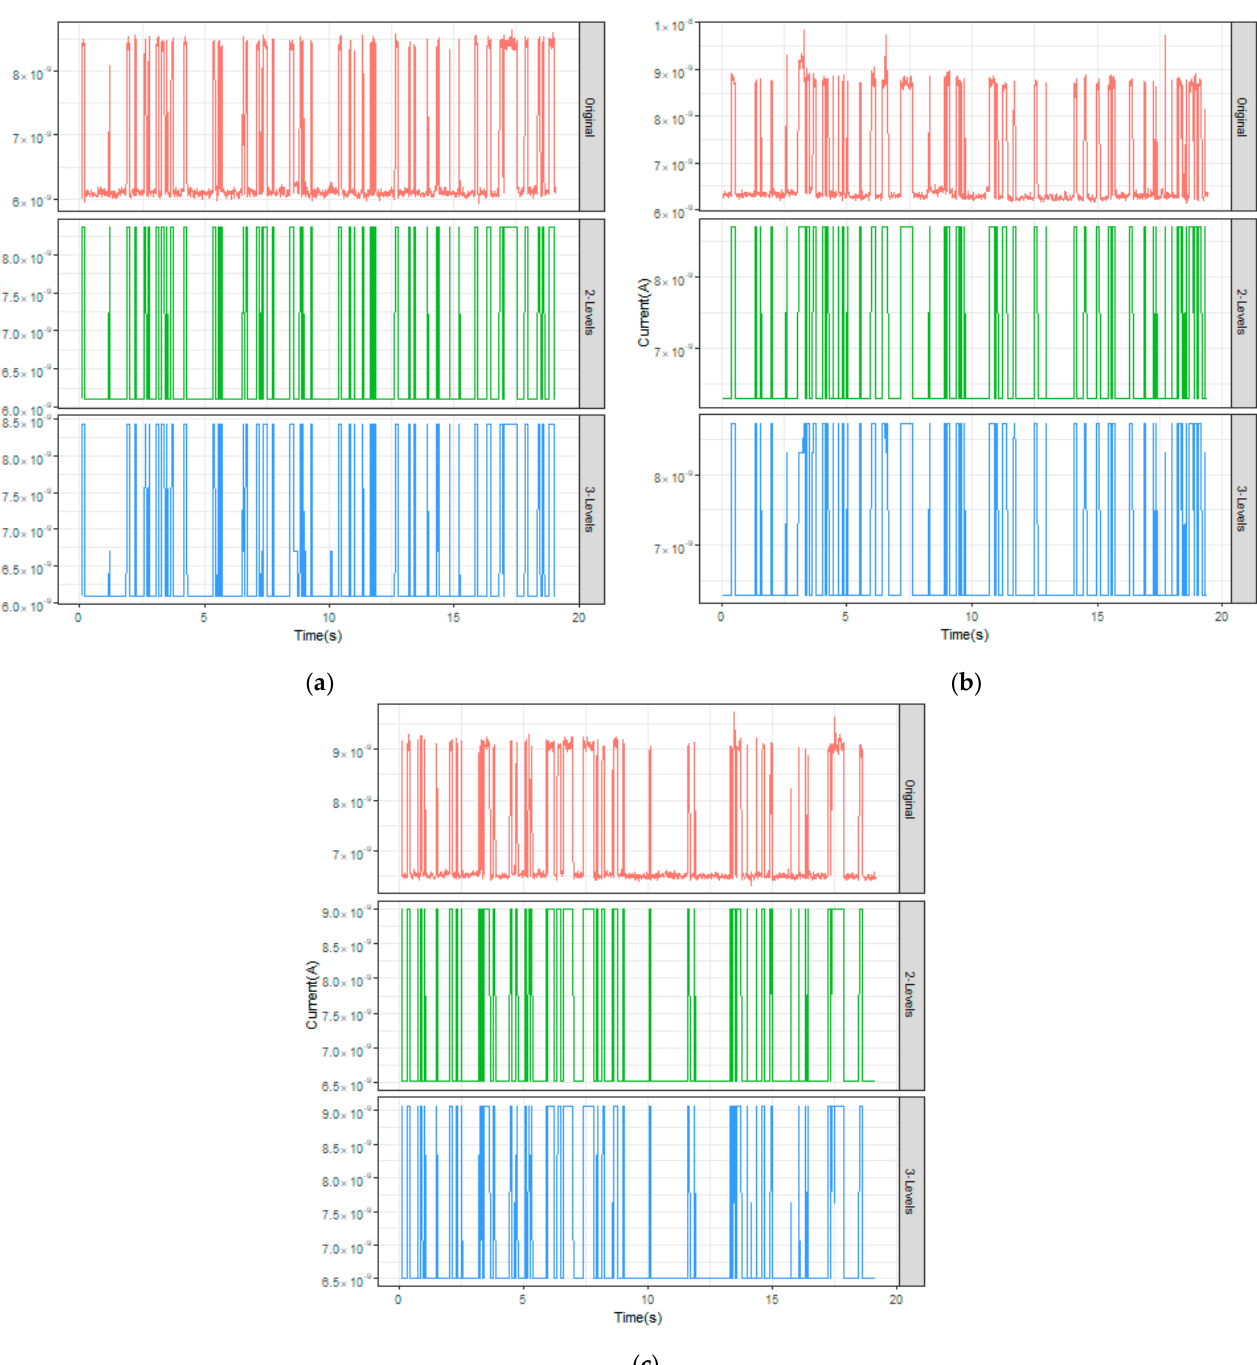
Figure 2. Fit obtained with the HMM for multiple latent states for the different RTN signals under study: ( a ) RTN25; ( b ) RTN26; ( c ) RTN27.